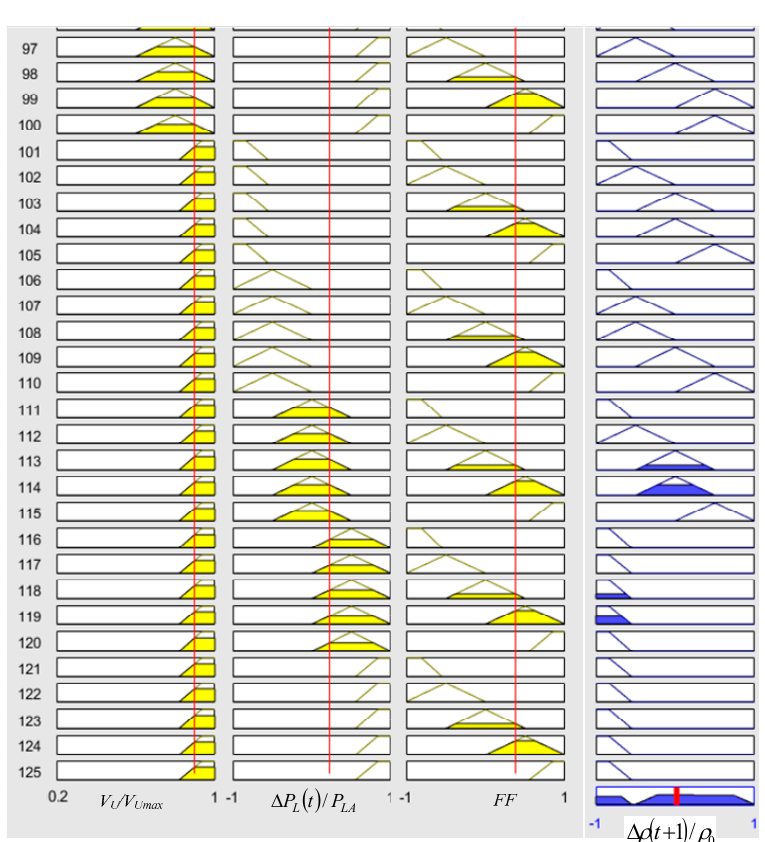
Figure 7. The sample of membership function that can represent the logic used in the design of the DRS.